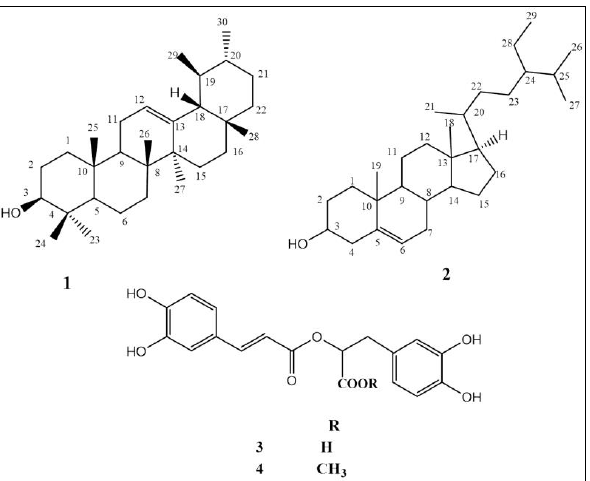
Figure 1. Chemical structures of isolated compounds from Cordia africana Lam.